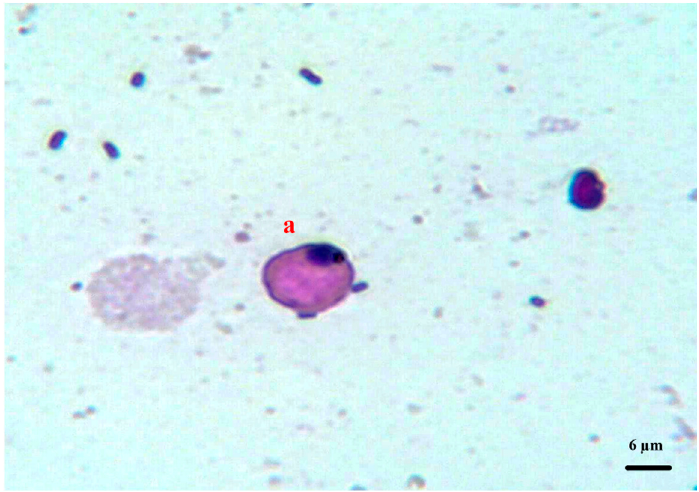
Figure 1. Immature sperm cell (a) stained with Diff-Quik from peregrine falcon semen samples (×1000).